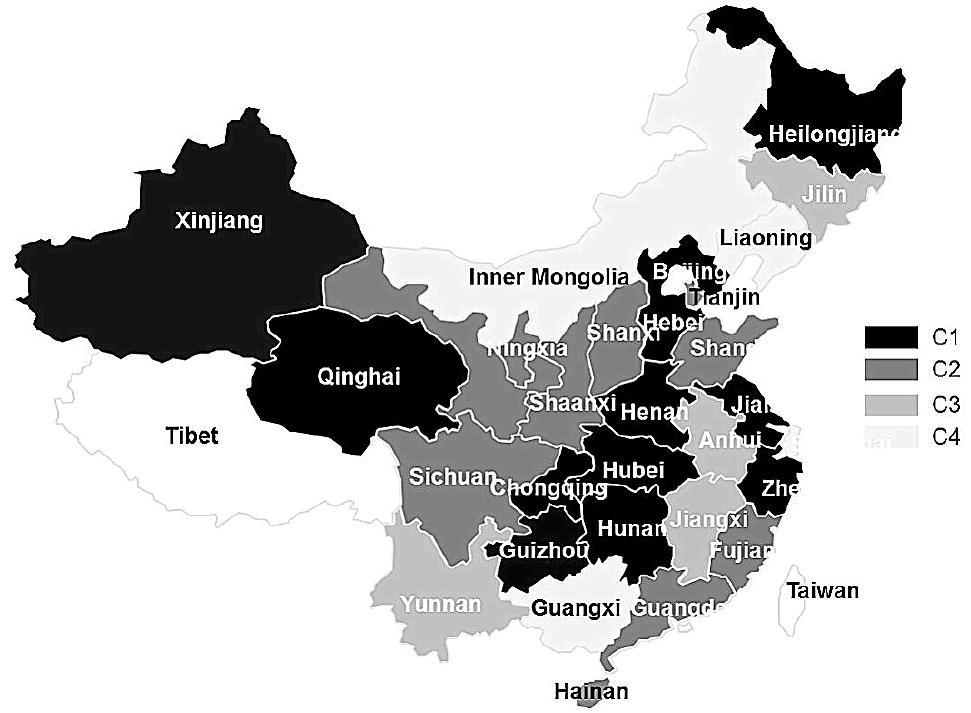
Figure 5. Cluster analysis distribution of FDI dynamic performance.